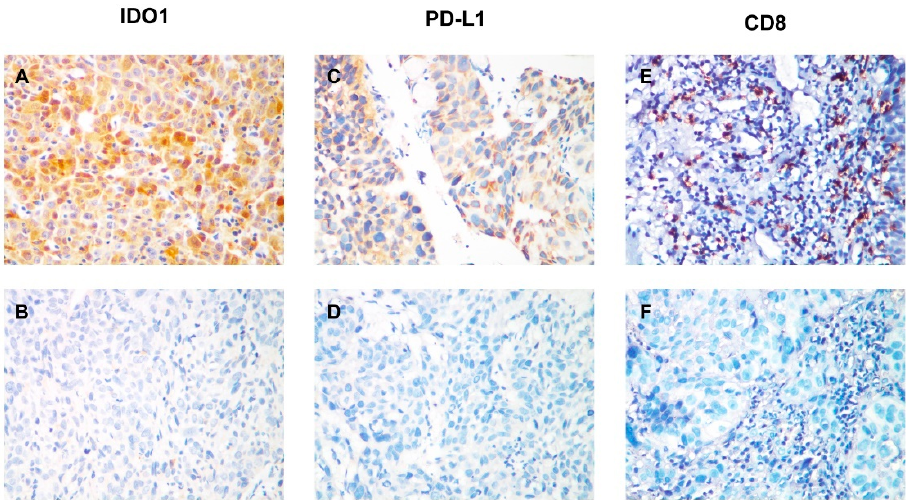
Figure 2. IDO1 and PD-L1 expression and CD8+ tumor-infiltrating lymphocyte (TIL) status in esophageal squamous cell carcinoma. ( A ) Positive immunohistochemical staining pattern for IDO1; ( B ) Negative immunohistochemical staining pattern for IDO1; ( C ) Positive immunohistochemical staining pattern for PD-L1; ( D ) Negative immunohistochemical staining pattern for PD-L1; ( E ) Pattern for high CD8+ TIL density; ( F ) Pattern for low CD8+ TIL density.